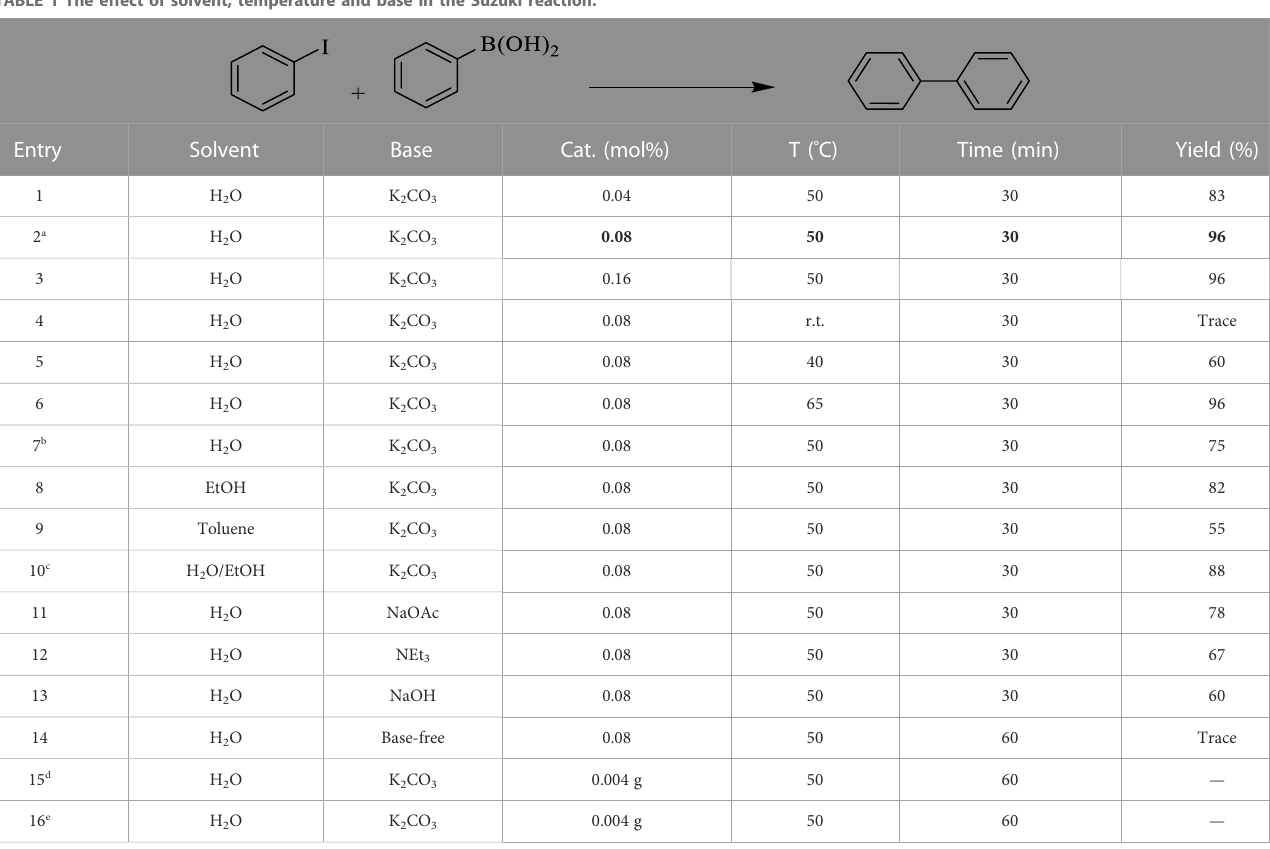
TABLE 1 The effect of solvent, temperature and base in the Suzuki